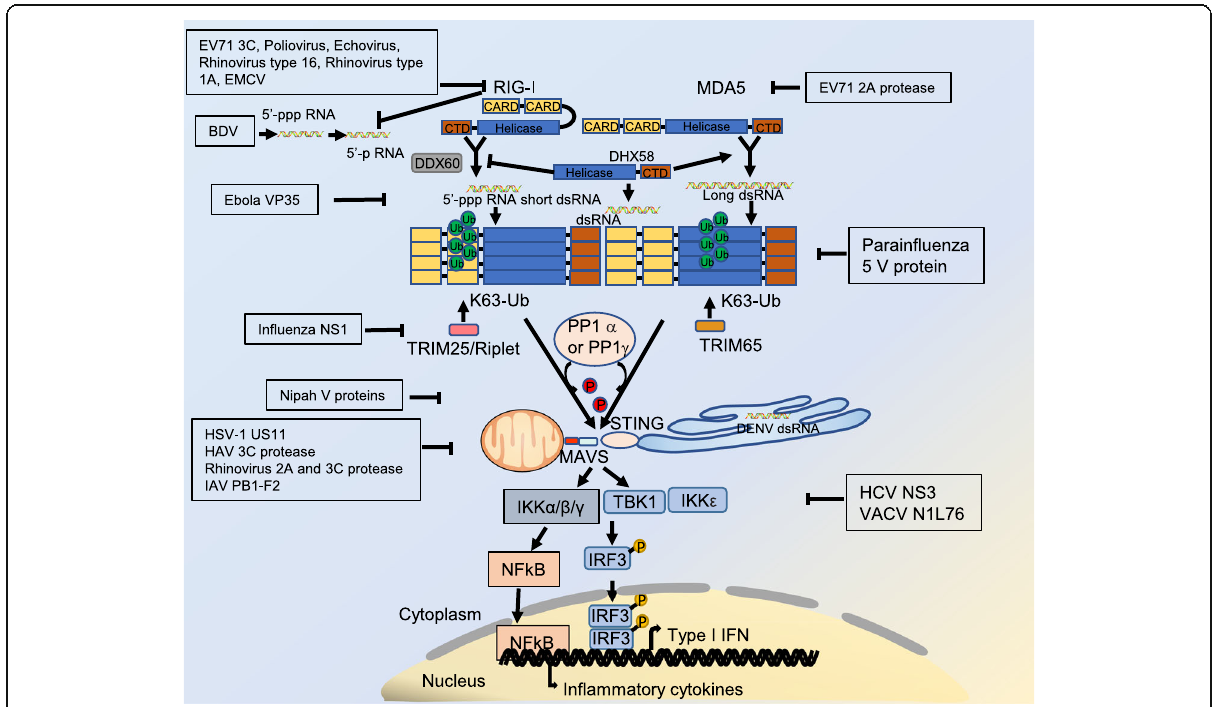
Fig. 3 Innate immune evasion strategies of targeting RLR signaling pathway . Viruses can escape from host immune clearance. For example, DENV can replicate in endoplasmic reticulum to efficiently hide dsRNA from the cytoplasm. BDV encodes phosphatases to process the 5 ′ -ppp on its genome to 5 ′ -p. The protein viral protein 35 (VP35) of EBOV can interact with dsRNA to prevent dsRNA from being detected by RLRs. Moreover, RLR signaling can be inhibited by viral proteins that either directly bind MDA5, RIG-I, MAVS, TBK1 to inhibit their function or induce their